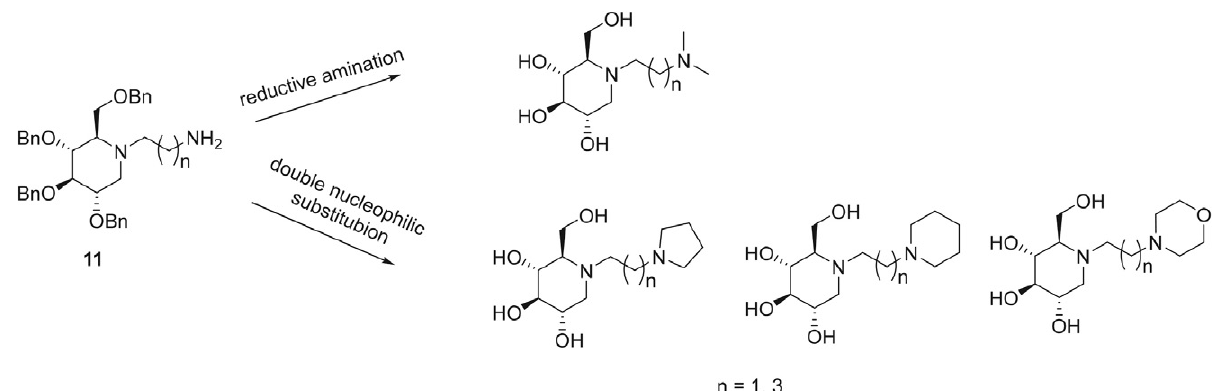
Figure 2. The key intermediate 11 and the general structures of the target compounds.